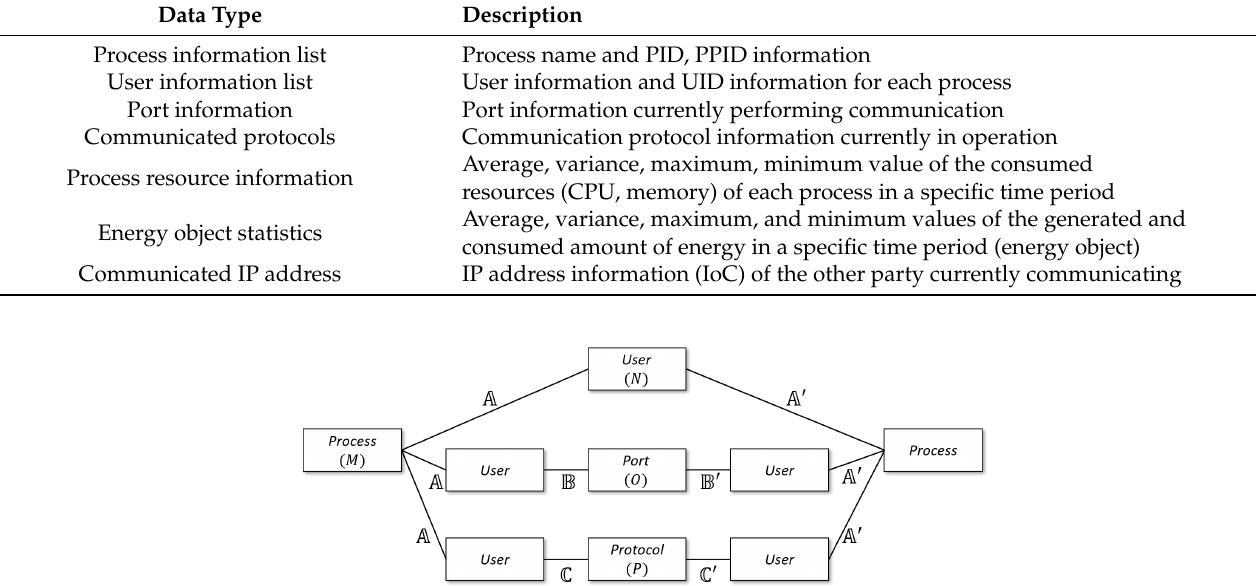
Table 1. Device status information and IoC data collected from prosumer devices. PPID, Parent Process Identification Number. Data Type